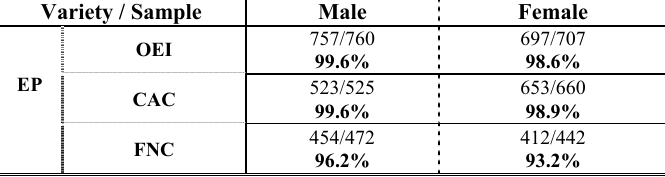
Table VIII: Third person plural verbal marking in EP and Sex/Gender Variety / Sample